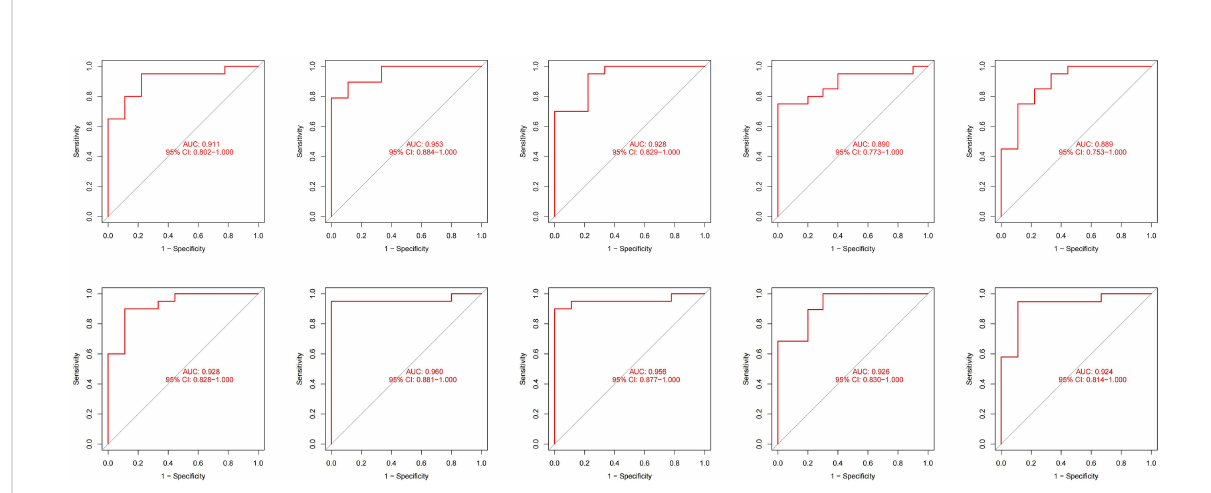
FIGURE 7 The ROC curve results were veri fi ed by 10-fold cross-validation under high-throughput conditions.